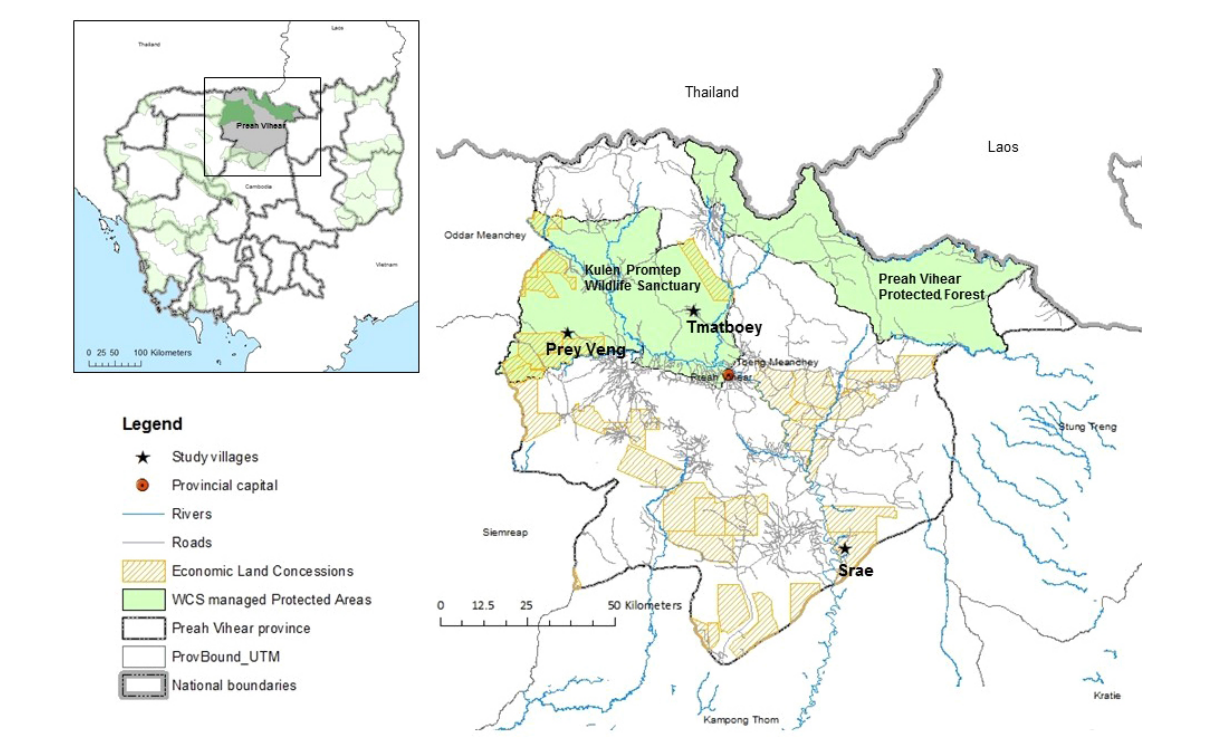
Fig. 2. Northern Plains landscape in Preah Vihear province, northern